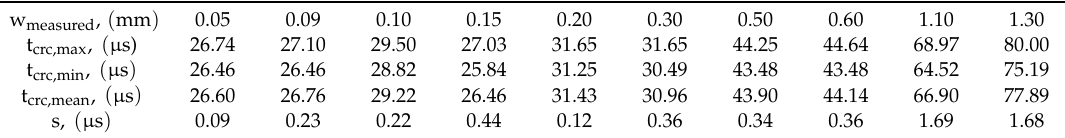
Table 1. Minimum, minimum, and mean value of t crack and standard deviation at di ff erent crack widths. w measured , ( mm )